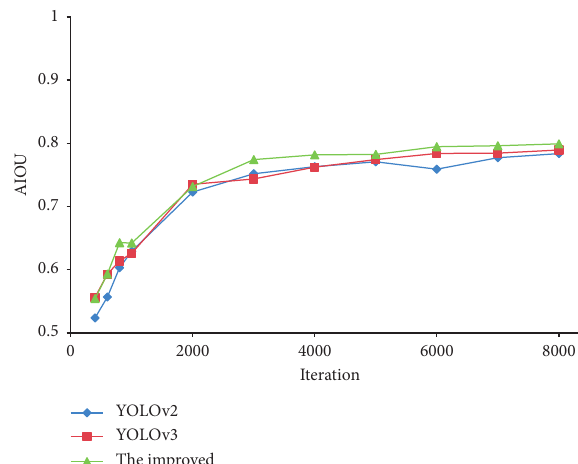
Figure 14: The comparison of AIOU among YOLOv2/v3 and the improved RDCNN under the